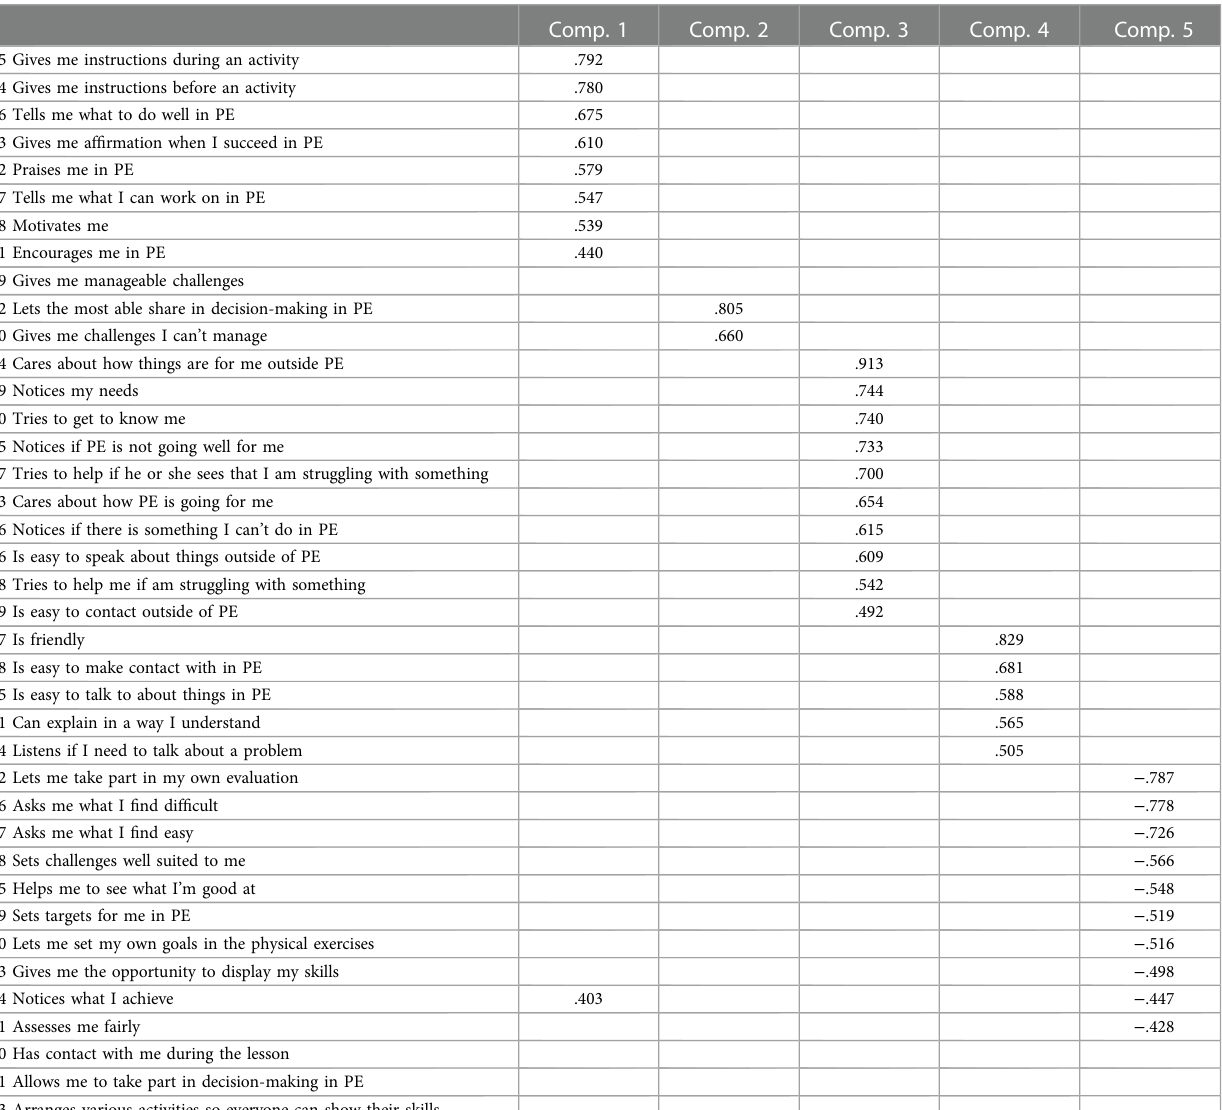
TABLE 2 Pattern matrix with all of the questions in the questionnaire and their factor loading.